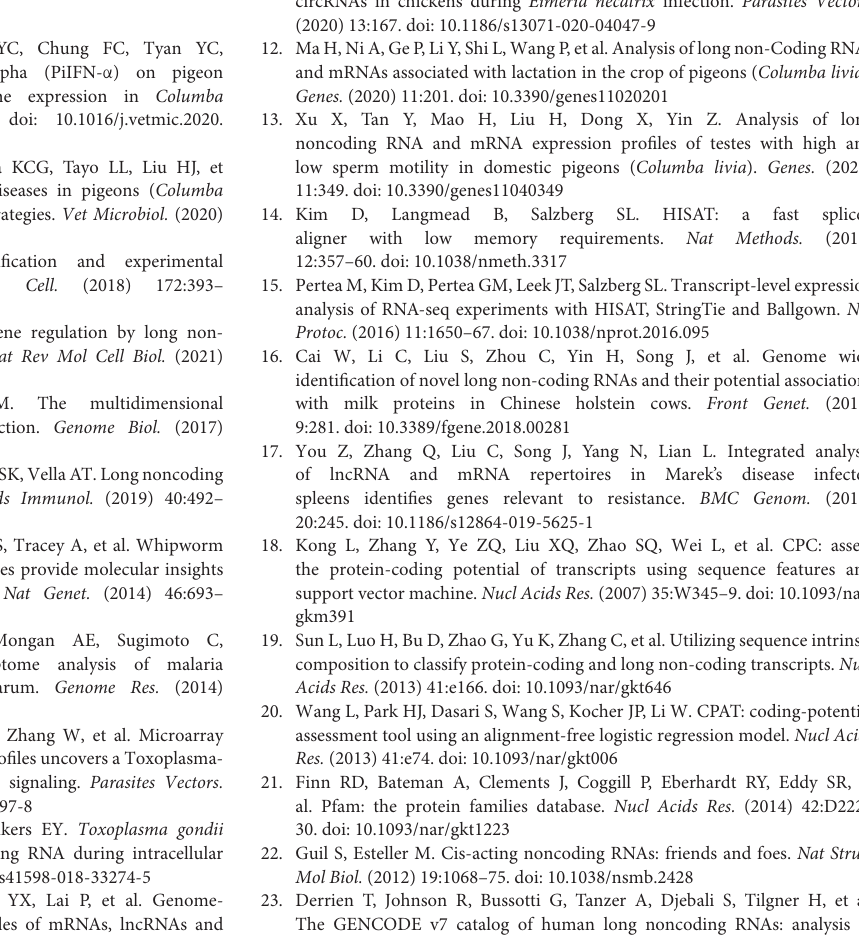
Supplementary Figure 1 | Chromosomal distribution of predicted lncRNAs. Intronic lncRNA, anti-sense lncRNA, intergenic lncRNA and sense lncRNA were plotted from interior to outside. The outermost layer means chromosome. Each bar denotes the density of lncRNA in the corresponding position. The central photo is white king pigeon. Supplementary Figure 2 | PCA plot of mRNA (A) and lncRNA (B) expression matrix for (control) N, S (susceptible), and T (tolerant) group. Supplementary Figure 3 | Differentially expressed (DE) lncRNAs and DE mRNAs within control vs. tolerant pigeons. The volcano plot of DE lncRNAs (A) and DE mRNAs (B) . The significantly up- and down-regulated candidates are presented as red or green dots, respectively, the gray dots represent transcripts whose expression levels did not reach statistical significance (fold change > 1.5 and P < 0.05). Cluster analysis of differentially expressed lncRNAs (C) and differentially Supplementary Figure 4 | Differentially expressed (DE) lncRNAs and DE mRNAs within control vs. susceptible pigeons. The volcano plot of DE lncRNAs (A) and DE